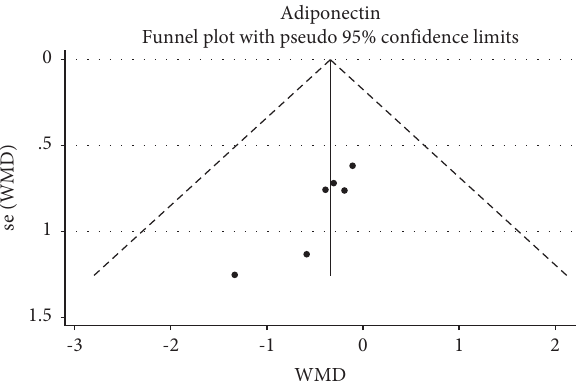
Figure 4: Funnel plot for evaluating publication bias in adiponectin.